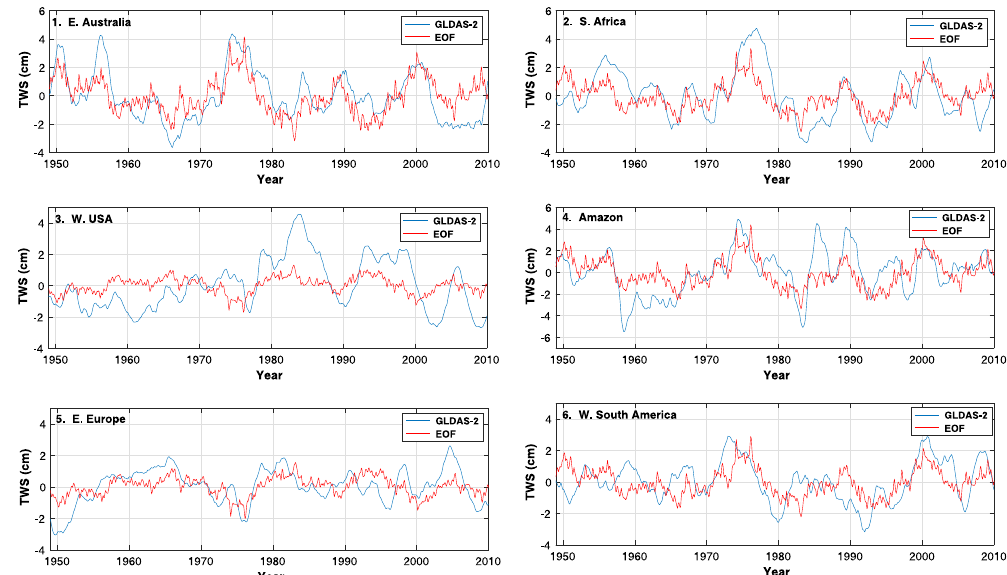
Figure 3. Comparison between GLDAS-2 TWS (after 2-year smoothing) and the contribution of the EOF mode shown in Fig. 1B to TWS. The time series for six separate regions are shown, matching the boxes shown in Fig.